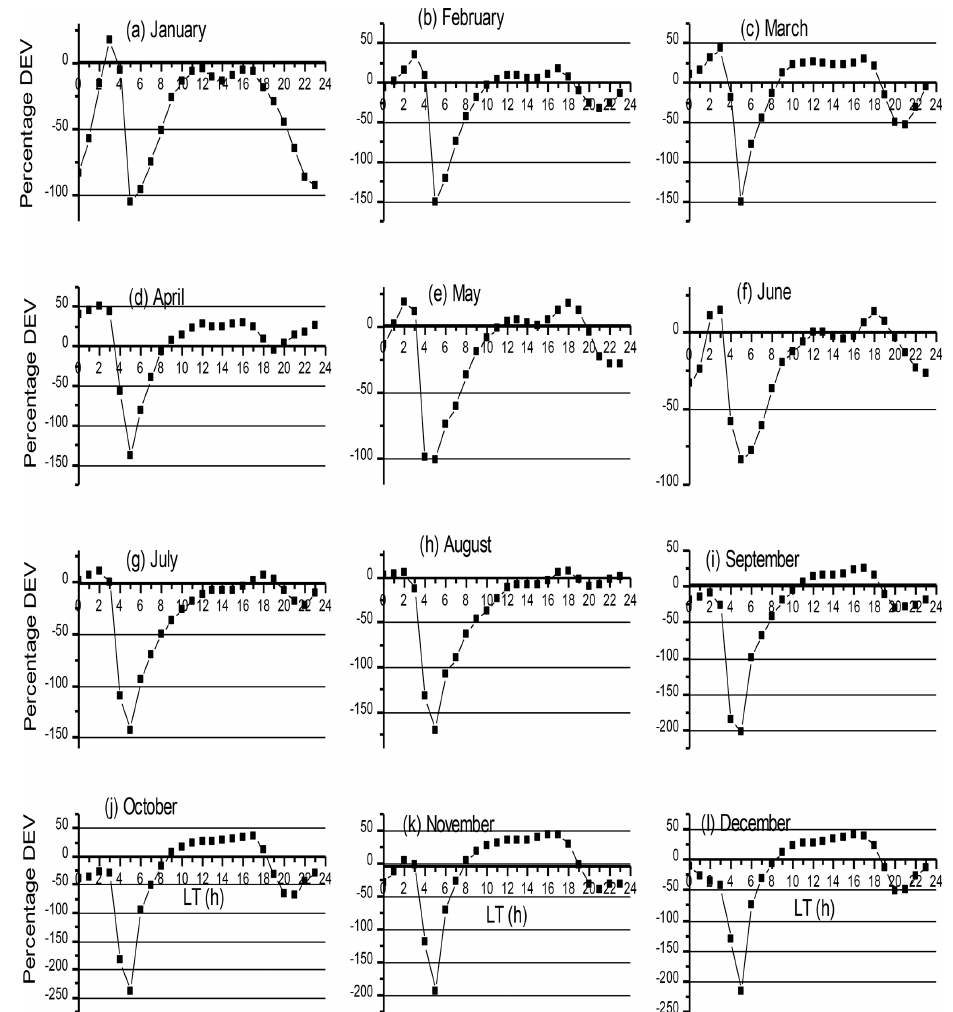
Figure 5. Percentage deviation of IRI-2016 from OBS-TEC for year